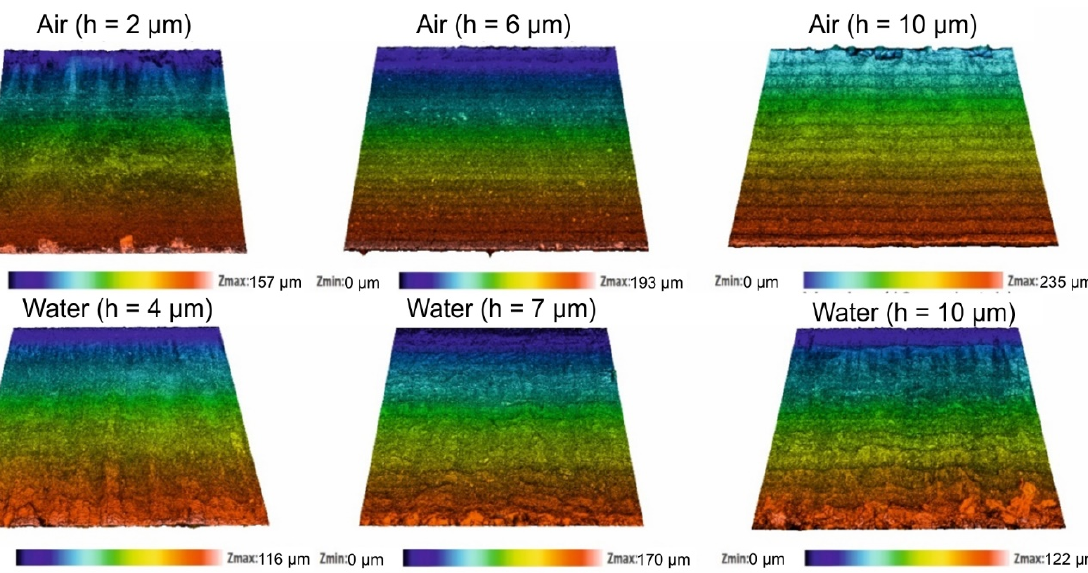
Figure 14. Topographies of cut sidewalls produced in ambient air and in water. Cases for three different hatch distances are presented (optimal, intermediate and ridge-free). Laser beam entry side is indicated with an arrow and applies to all panels in the figure.